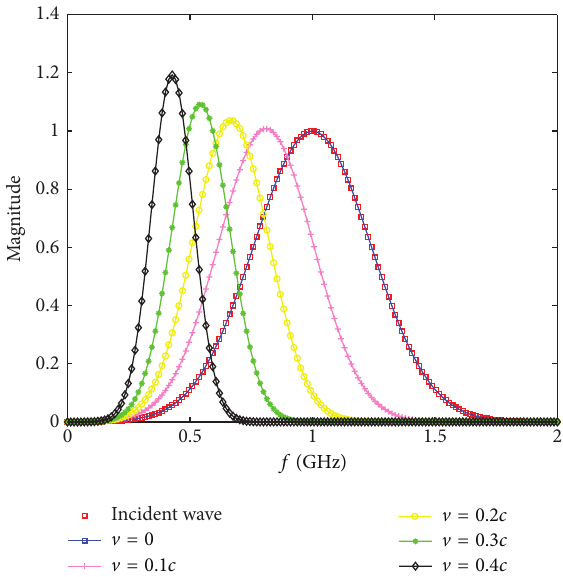
Figure 10: Frequency spectrums of the moving conducting surface excited by the modulated Gaussian pulse.